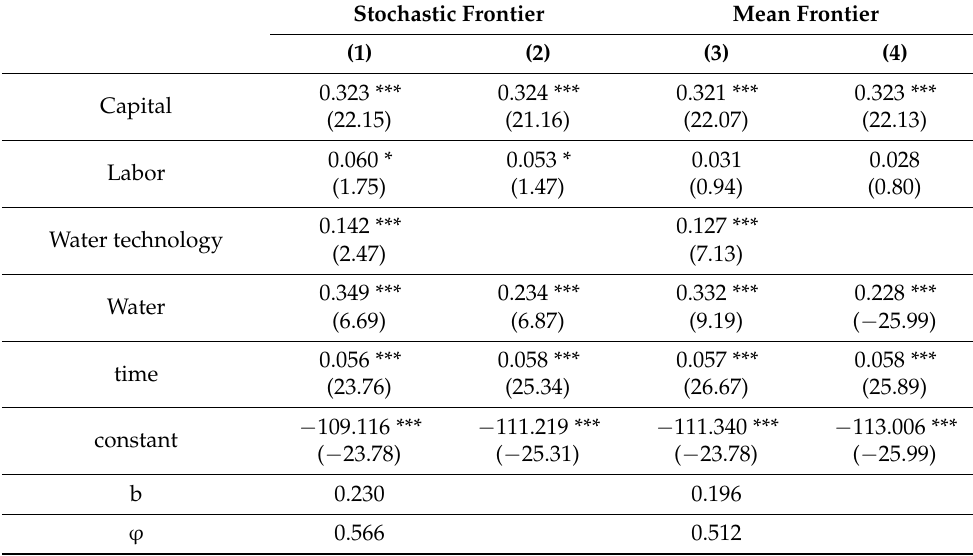
Table 3. Econometric estimates of frontier economic effects of water technology. Stochastic Frontier Mean